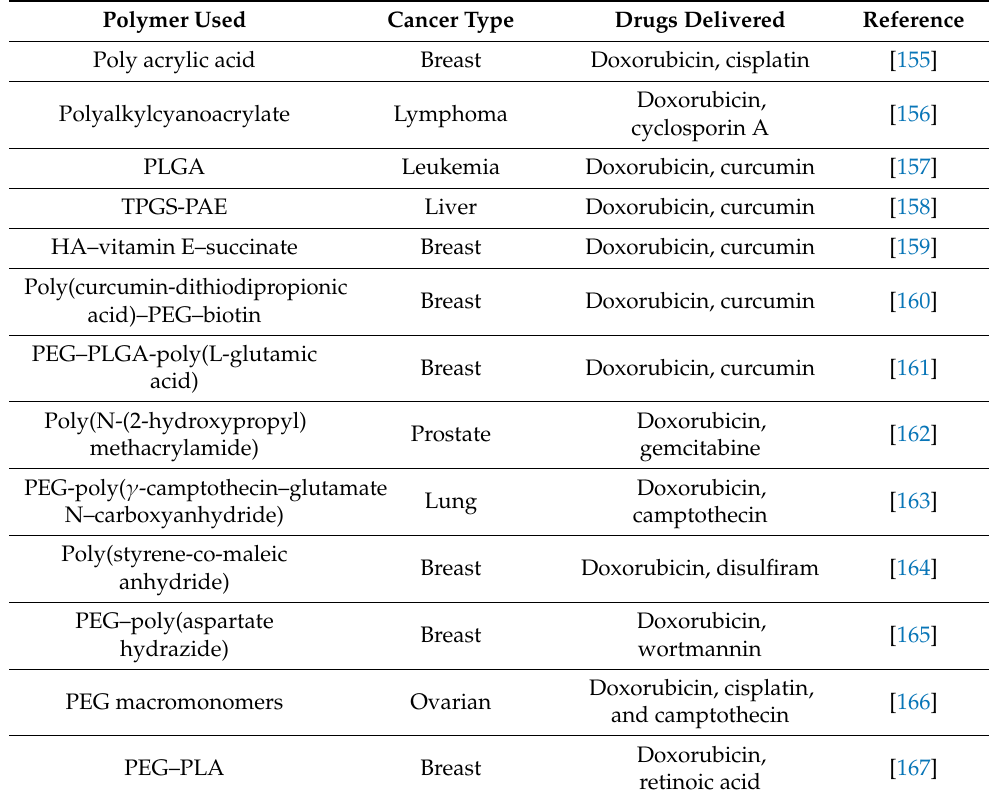
Table 2. Summary of studies using polymeric nanoparticle systems to deliver doxorubicin-based combination